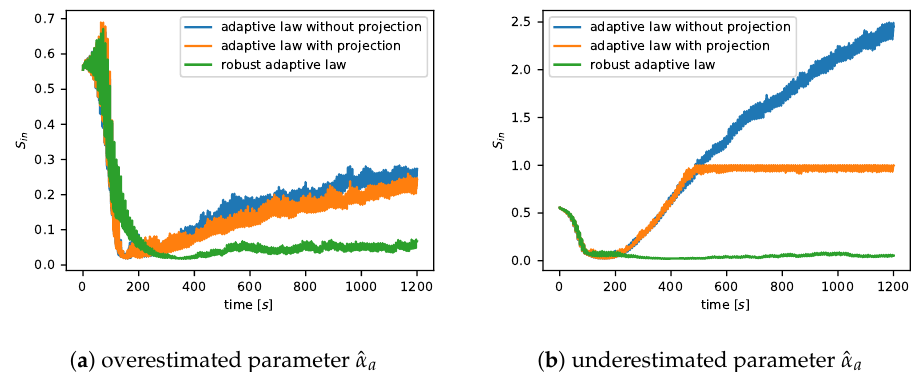
Figure 7. The transients of function S in for different adaptation